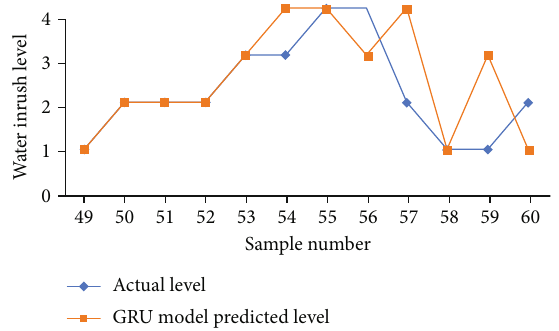
Figure 7: Prediction results of the GRU model.